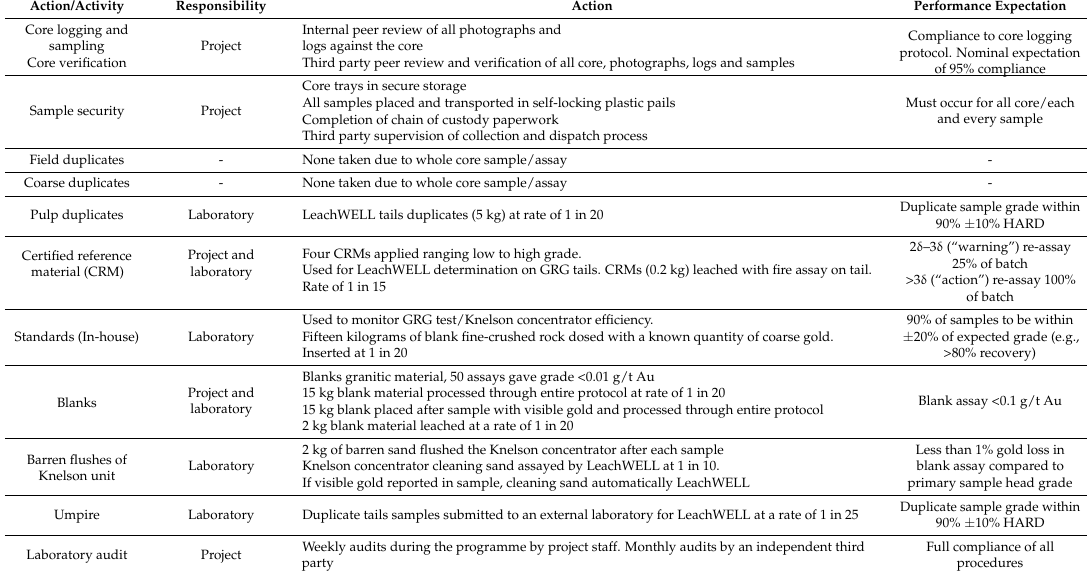
Table 3. Summary of QAQC applied during the geometallurgical drilling